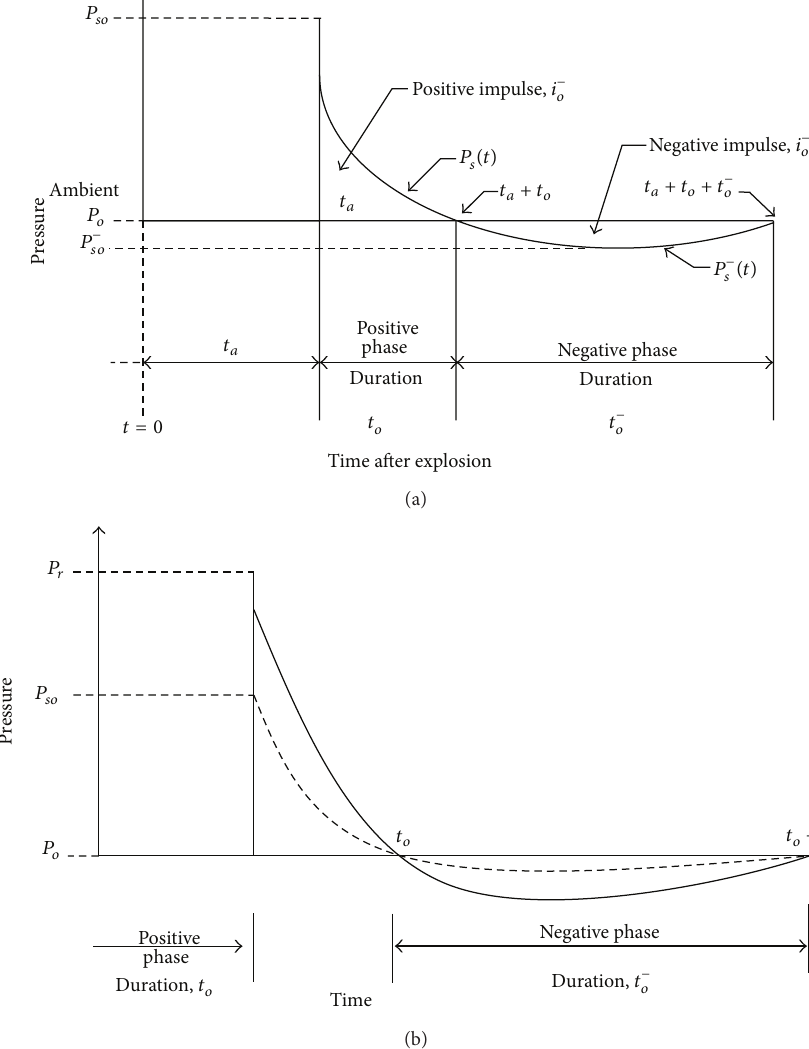
Figure 3: (a) Blast wave pressure-time graph. (b) Blast load and comparison